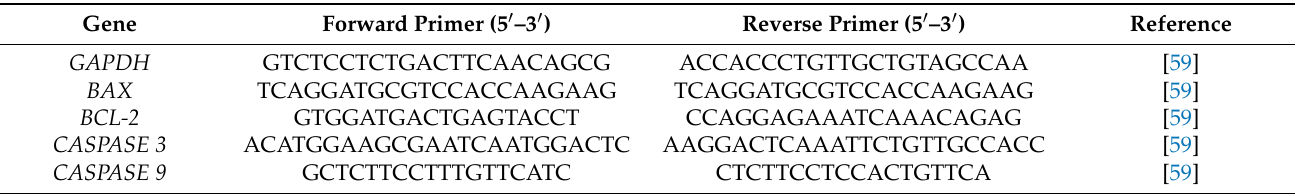
Table 2. List of apoptosis-related gene primers used in the study. Gene Forward Primer (5 (cid:48) –3 (cid:48) ) Reverse Primer (5 (cid:48) –3 (cid:48)